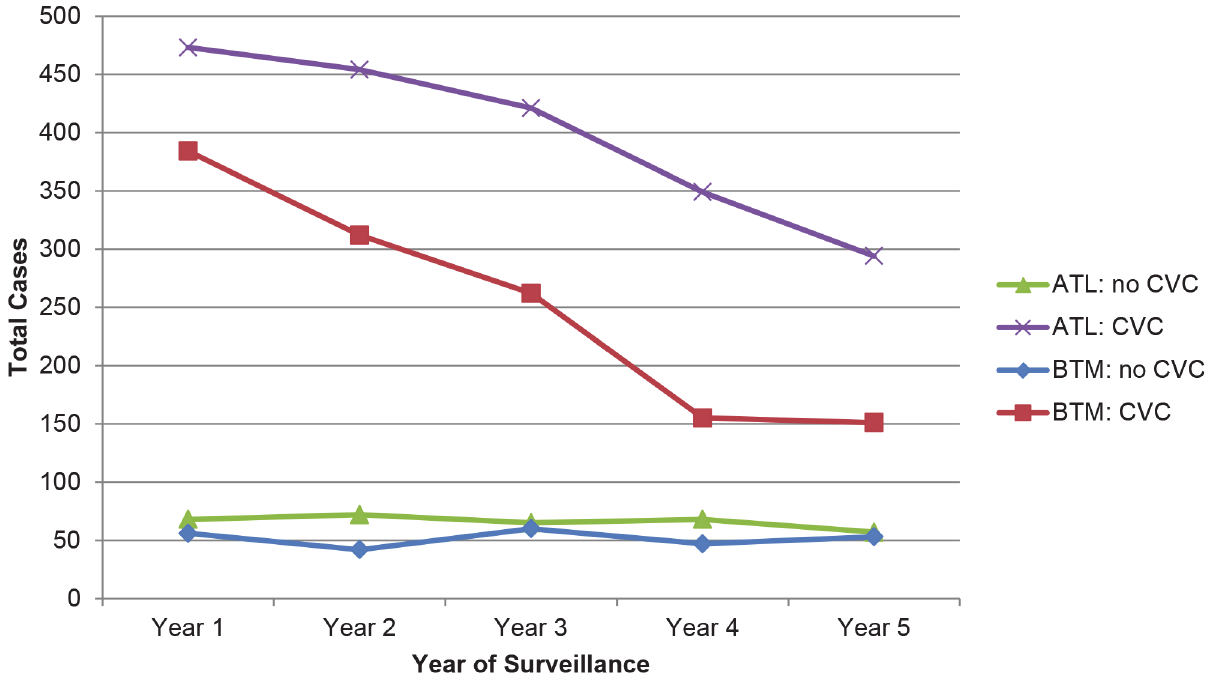
Fig 5. Candidemia cases that had a CVC compared with cases that had no CVC, in Atlanta (ATL) and Baltimore (BTM), 2008 –